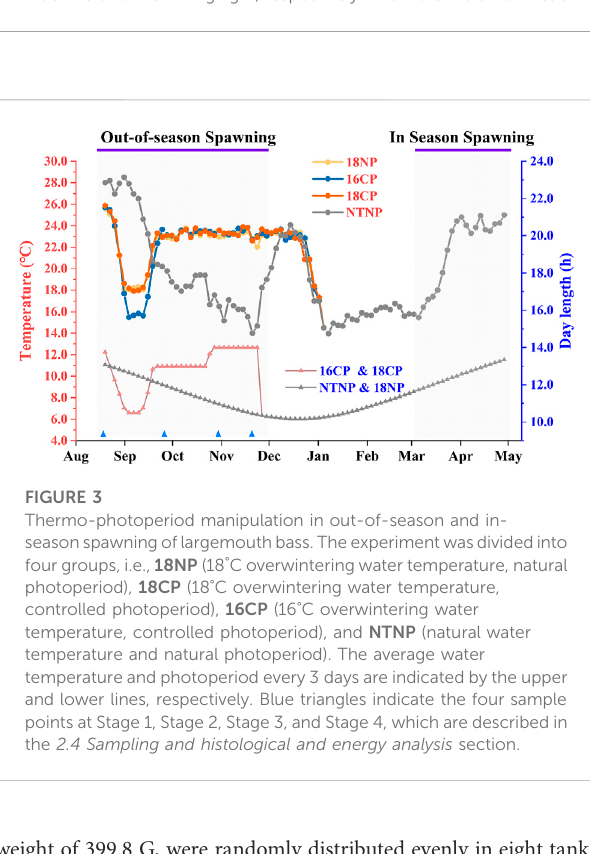
weight of 399.8 G, were randomly distributed evenly in eight tanks (25 ind. per tank). Four groups, i.e., 18NP (18 ° C overwintering water temperature, natural photoperiod), 18CP (18 ° C overwintering water temperature, controlled photoperiod), 16CP (16 ° C overwintering water temperature, controlled photoperiod), and NTNP (natural water temperature and natural photoperiod), were arranged with two replicates for each. The average initial weights of 18NP , 18CP , 16CP , and NTNP groups were 400.4 ± 69.6, 399.0 ± 76.6, 399.8 ± 76.8, and 389.9 ± 58.2 g, respectively.